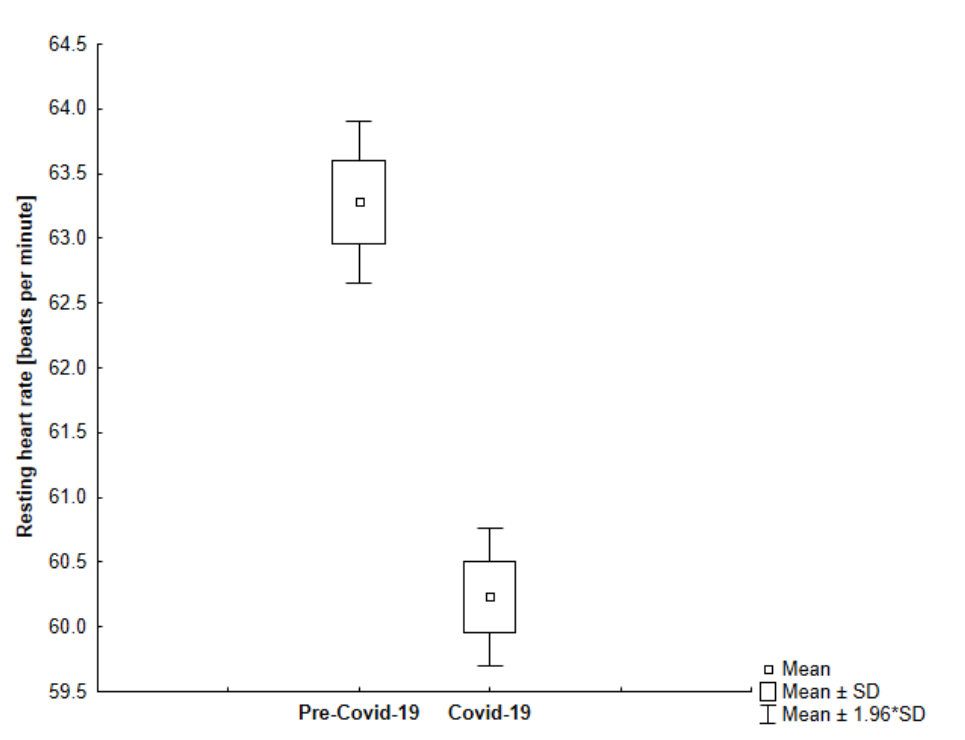
Figure 6. The comparison of the average resting heart rate in the analyzed periods ( p < 0.001).